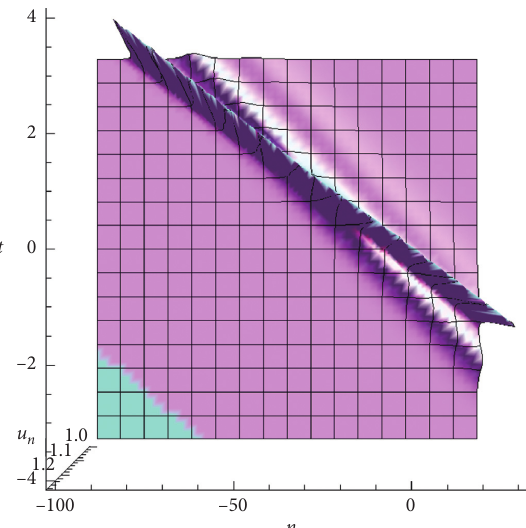
Figure 9: Spatiotemporal structure of the semidiscrete three-soliton solution determined by solution (53) with the parameters α � 1, α � 1, α � 1, c ( 0 ) � 1, c ( 0 ) � 2, c ( 0 ) � − 3, z α 1 2 3 1 2 3